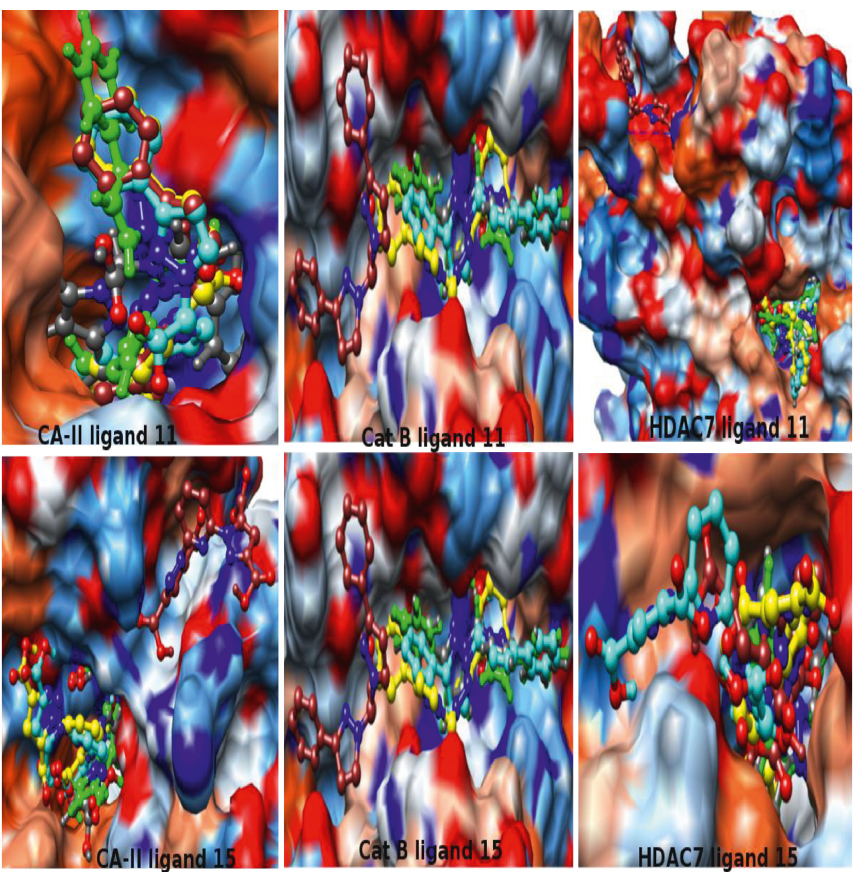
F IGURE 2: The binding site interaction of the ligands 11 and 15 with CA-II, ligand 11 with Cat B, and ligands 11 and 15 with HDAC7 using Molegro-QC (grey), Molegro (green), Vina (brown), AutoDock-QC (yellow), and AutoDock (cyan) methods.